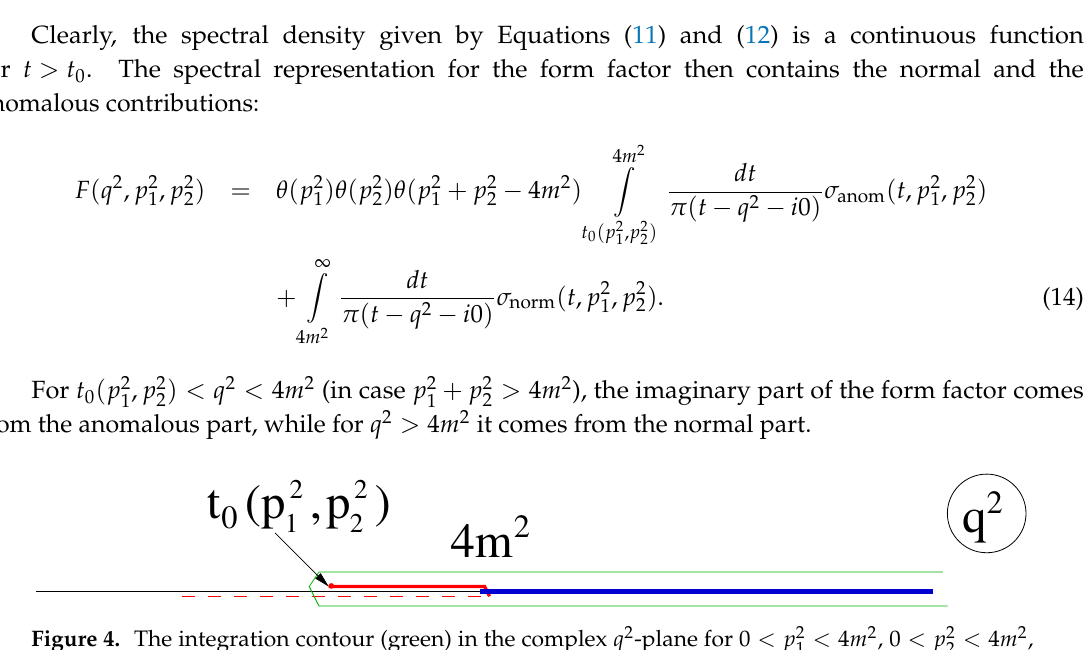
Figure 4. The integration contour (green) in the complex q 2 -plane for 0 < p 2 + p 2 > 4 m 2 : it embraces the anomalous cut (the solid red segment from t and p 2 2 1 the normal cut (blue line from 4 m 2 to + ∞ ). The dotted red line displays the trajectory of the branch ) on the unphysical point t 0 ( p 2 , p 2 2 1